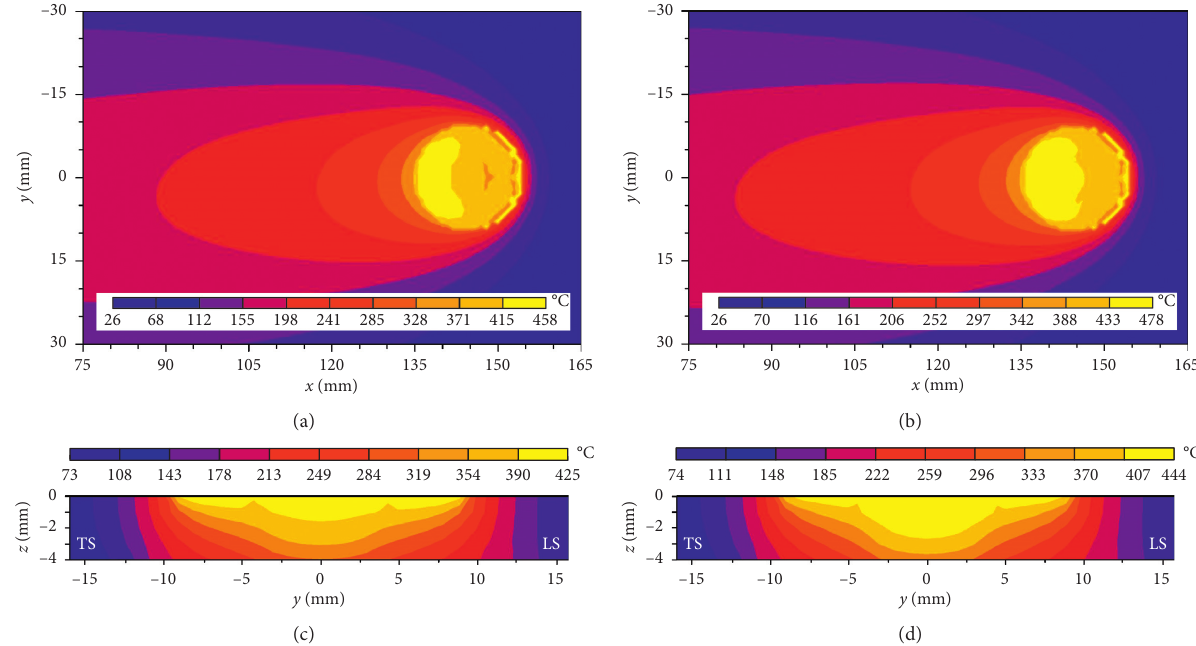
Figure 18: The predicted temperature distributions on different sections in the traverse stage. (a) Top surface in the CAM. (b) Top surface in the MAM. (c) Transverse section in the CAM. (d) Transverse section in the